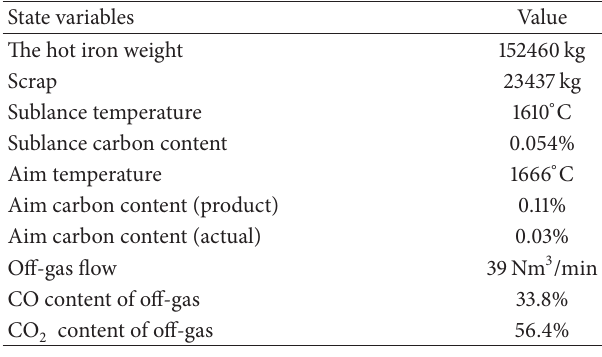
Table 4: Comparable results for the minimum function values of some algorithms.